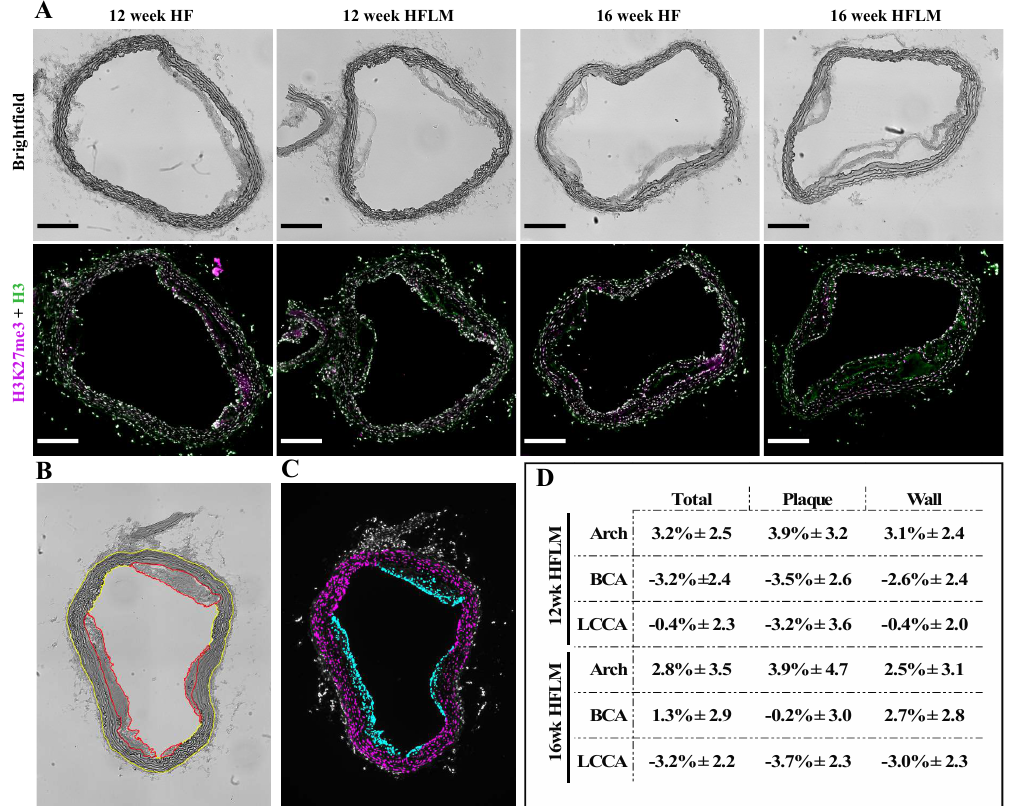
Figure 6. Immunofluorescent (IF) analysis ( A ) Brightfield and IF images of aortic arch cross sections from ApoE − / − mice fed either a High Fat (HF) or a High Fat Low Methyl donors (HFLM) diet for 12 or 16 weeks (wk) as indicated. Total Histone 3 (H3) in green, and Histone 3 trimethylated at lysine 27 (H3K27me3) in magenta. Scale bars = 200 µ m. ( B ) Example of the manual segmentation using FIJI (ImageJ) to define Plaque (Red) and Wall (Yellow); ( C ) Example of the Plaque Nuclei (Cyan) and Wall Nuclei (Magenta) segments used to measure mean fluorescence ratios of H3K27me3:H3; ( D ) Variation of the relative H3K27me3 content in the HFLM aortas in relation to the corresponding HF aortas expressed as percent change; data are the mean ± SEM, n = 25. BCA, brachiocephalic artery; LCCA, left common carotid artery (localization shown in Figure 1A).